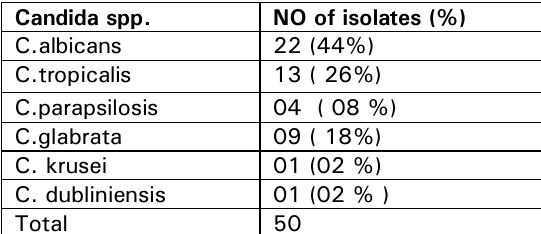
Table 2: Species of candida isolated Candida spp.